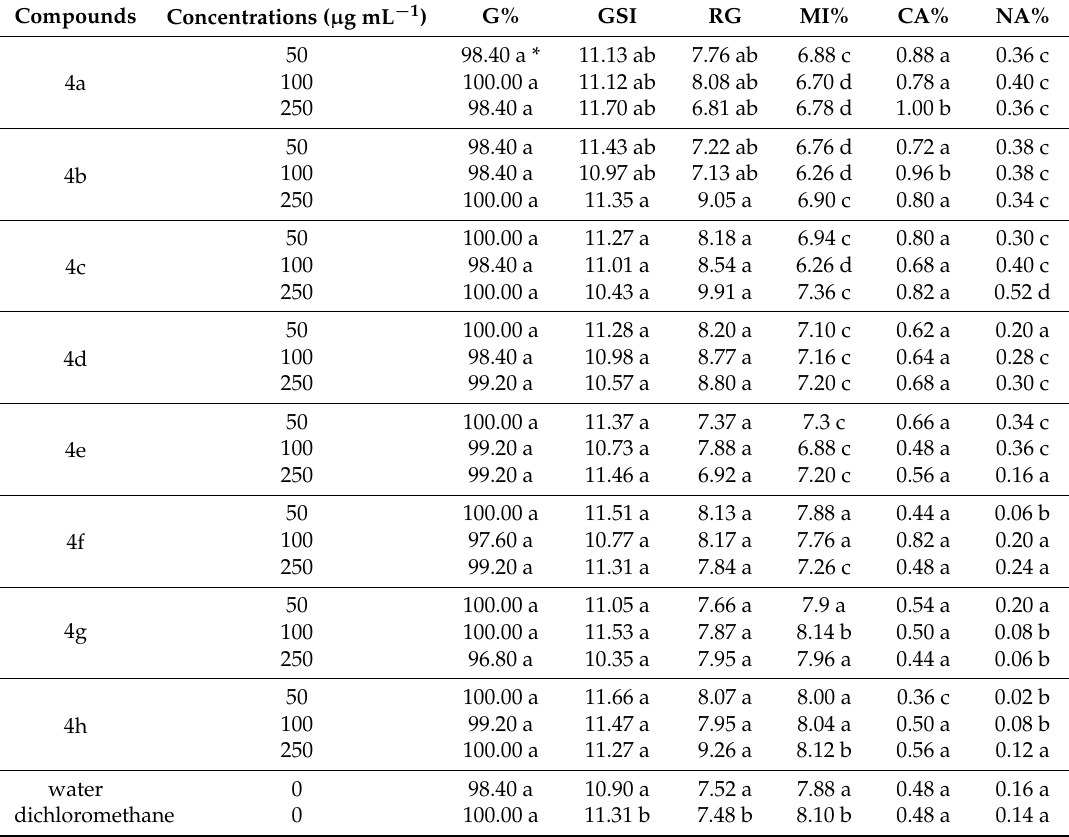
Table 4. Macroscopic and microscopic parameters evaluated in Lactuca sativa seeds treated with the triazoles 4a – 4h at three concentrations and negative controls (distilled water and dichloromethane).